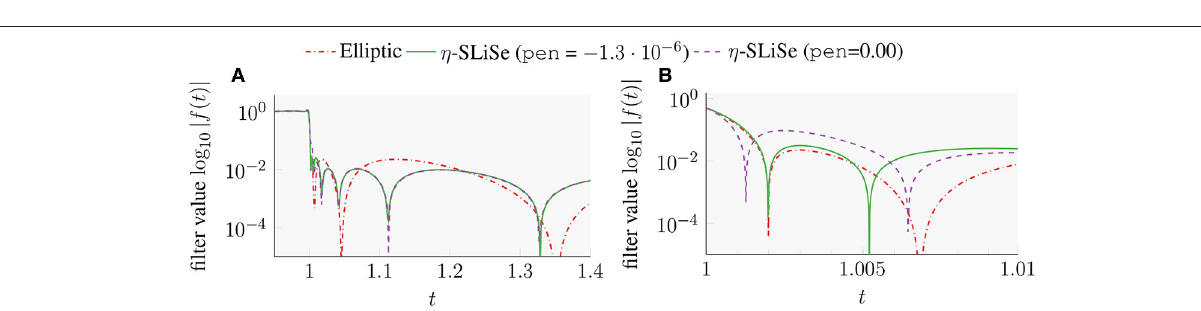
FIGURE 9 | Plots of the Elliptic filter, η -SLiSe, and the η -SLiSe filter without penalty term. All filters have 16 poles and coefficients. (A) Semi-log plot. (B) Semi-log plot. Abscissa limited to [1,